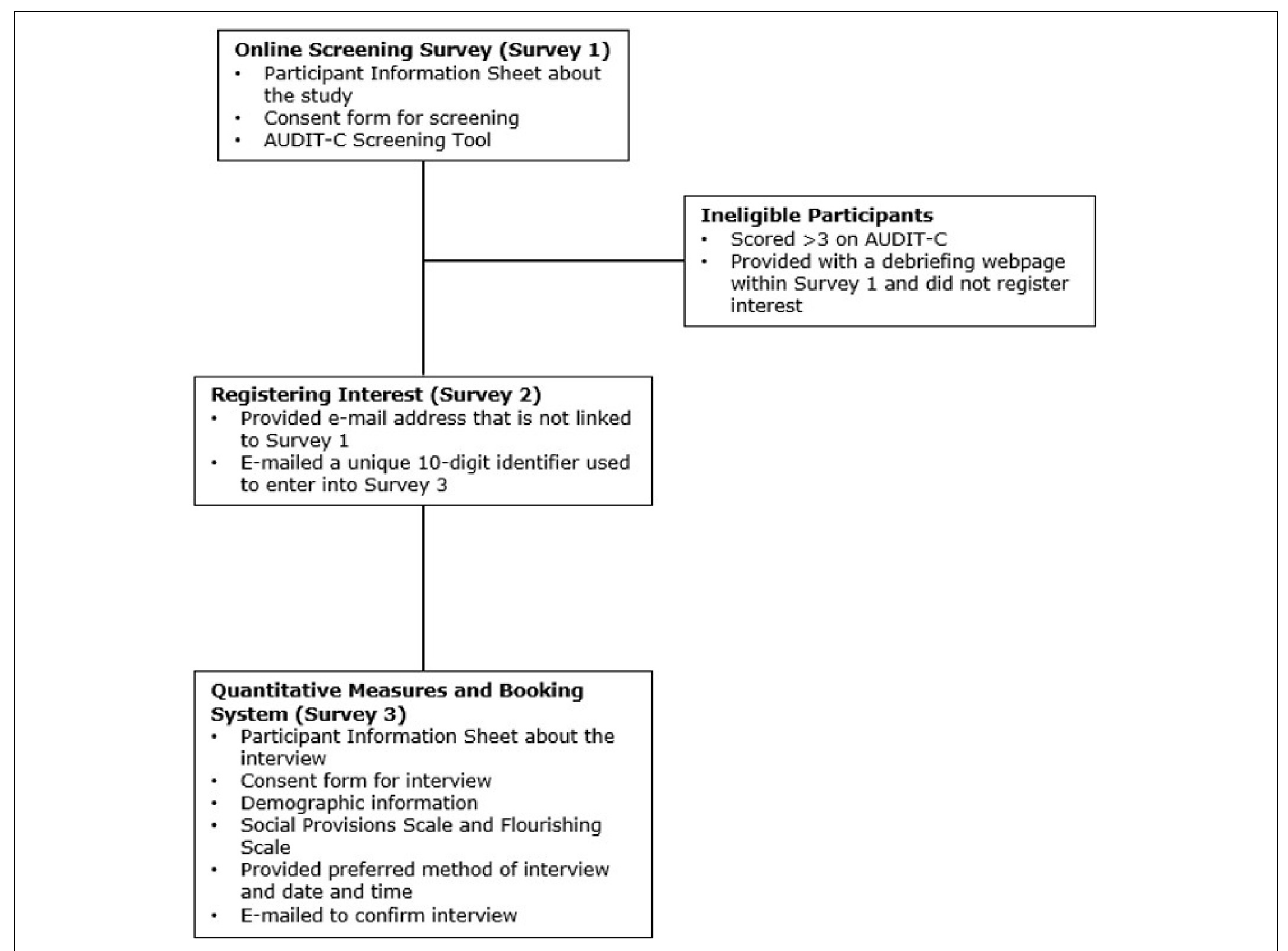
FIGURE 1 | Procedural flow of participants through the